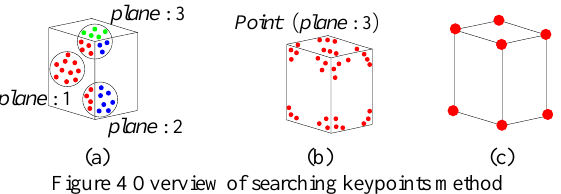
Figure 3. Overview of local shape matching